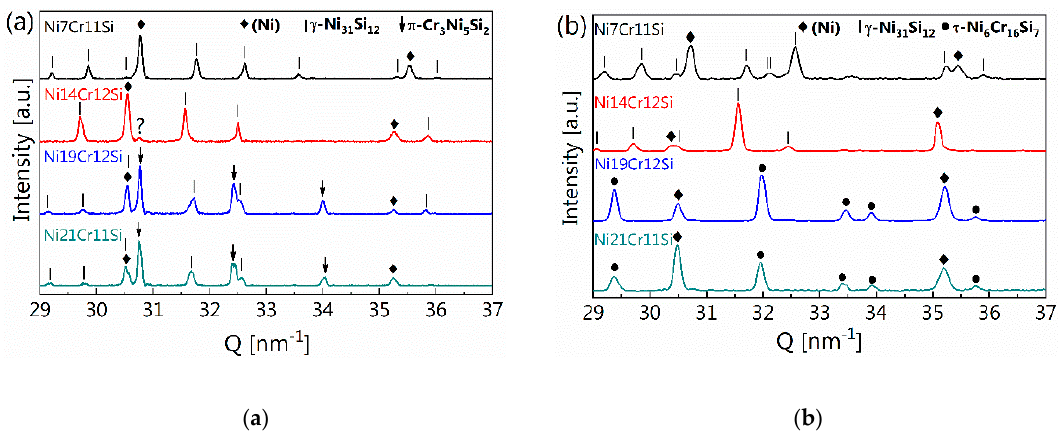
Figure 4. ( a ) Post mortem XRD patterns of the spheres with r = 2 mm (i.e., 1600 K s − 1 ); ( b ) 1D profiles of synchrotron diffraction patterns of spheres with r = 0.5 mm (i.e., 11000 K s − 1 ). Compared with lab XRD device, the synchrotron gives a much better signal to background ratio, so the diffraction pattern collected at t = 0 s is plotted in ( b ). Q is the diffraction vector, i.e., momentum transfer in reciprocal space, which is a material characteristic parameter. The rhombus means the peaks for (Ni), solid line for γ -Ni31Si12 and dot for τ -Cr6Ni16Si7. Table 2. Phases observed in the alloys after solidification at different cooling rates and phases predicted according to Scheil simulations.